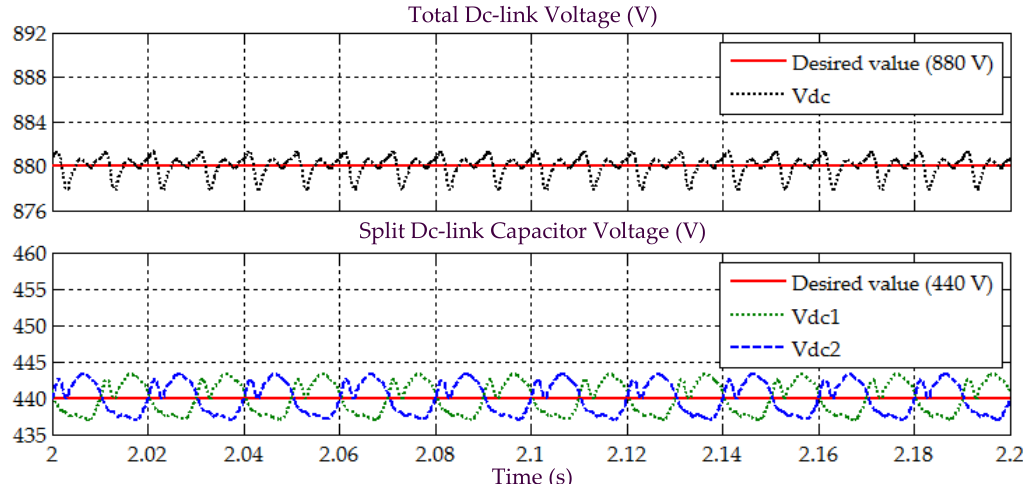
Figure 9. Simulation result obtained under Scenario A for Load 2, showing the total dc-link voltage 𝑉 𝑑𝑐 , and voltages across split dc-link capacitors 𝑉 𝑑𝑐1 and 𝑉 𝑑𝑐2 , demonstrated by SAPF while applying the proposed STF- dq 0 technique.